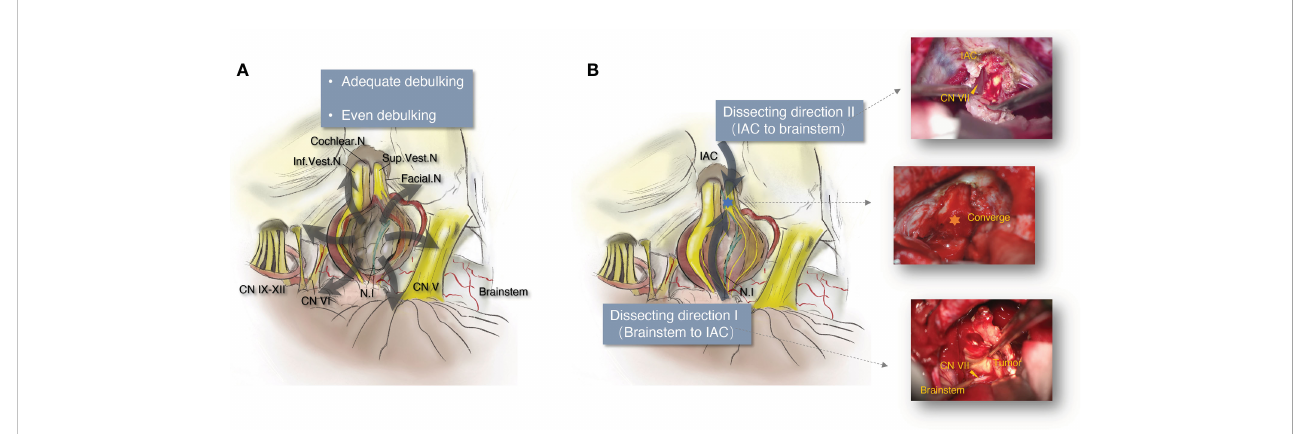
FIGURE 1 The schematic diagram illustrating the principle of vestibular schwannoma microsurgery for neurofunction preservation. (A) Schematic diagram of even and adequate debulking in vestibular schwannoma microsurgery. (B) Schematic diagram and intraoperative images of bidirectional dissection in vestibular schwannoma microsurgery. IAC, internal acoustic canal; Cochlear. N, cochlear nerve; Facial. N, facial nerve; Sup.Vest.N, superior vestibular nerve; Inf.Vest.N, inferior vestibular nerve; CN V, the 5th cranial nerve; CN VI, the 6th cranial nerve; CN IX – XII, the 9th to 12th cranial nerves.